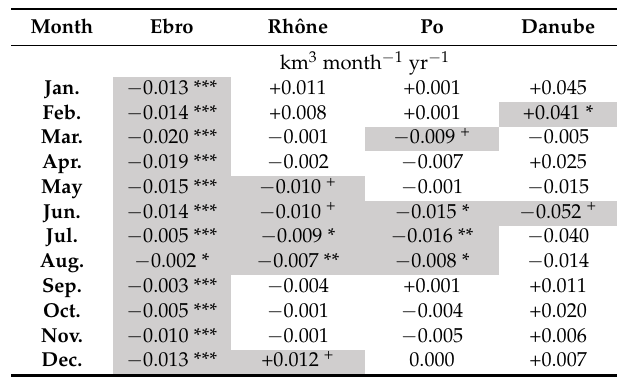
Table A1. Slope (km 3 month − 1 yr − 1 ) of monthly integrated river discharge (km 3 month − 1 ) vs. time (yr) in flow series of Table 1 estimated by MKT and ST. The levels of significance of these trends are highlighted in gray (*** α = 0.001, ** α = 0.01, * α = 0.05, + α = 0.1, no symbols α > 0.1).